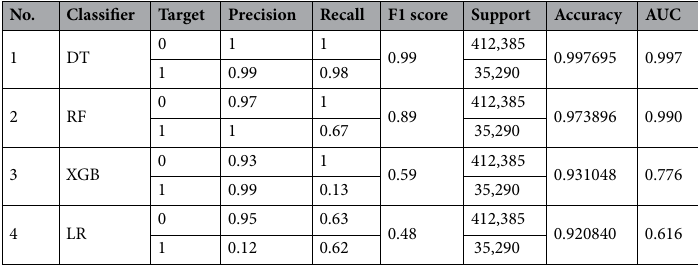
Table 4. Metrics for the second